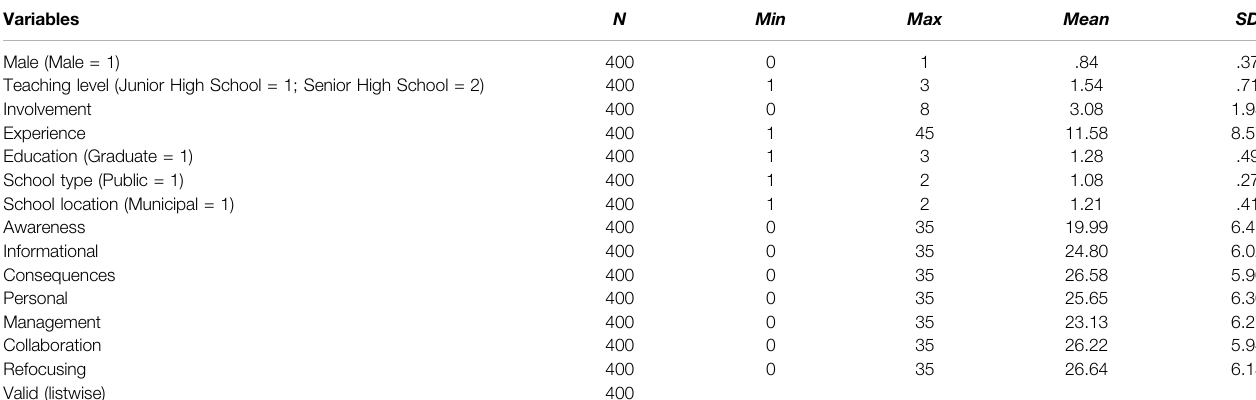
TABLE 4 | Descriptive statistics for the Philippine teachers.